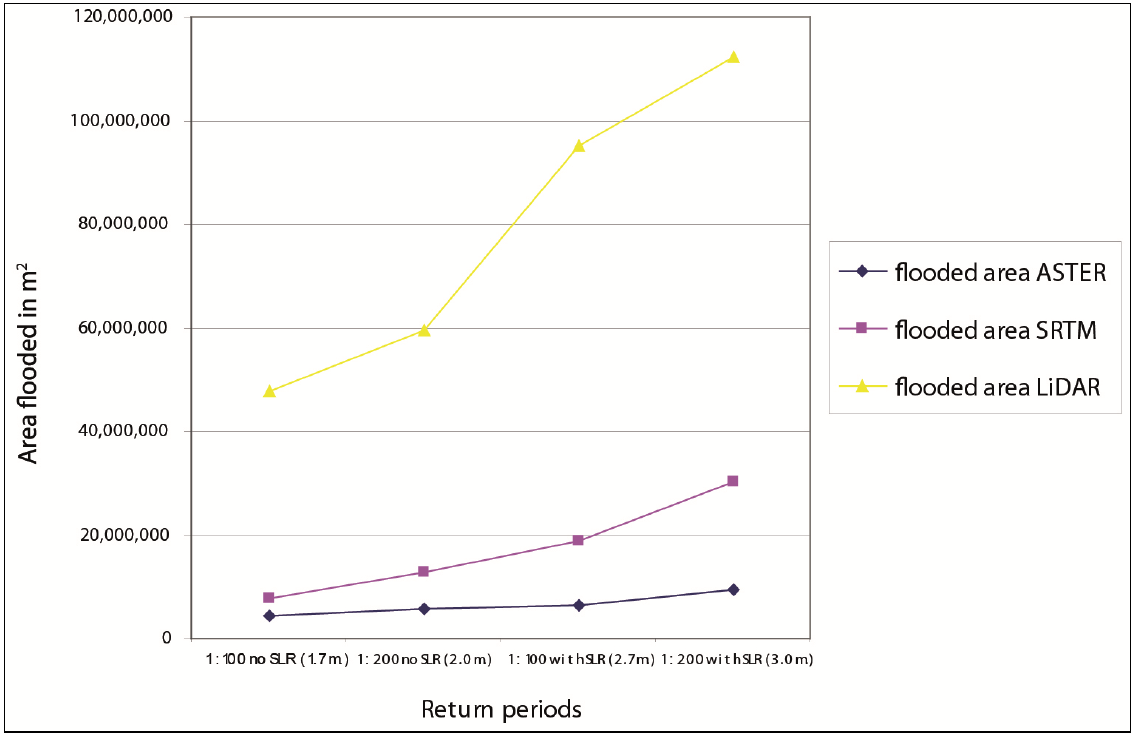
Figure 8. Flooded area estimated by ASTER, SRTM and LiDAR for Lagos